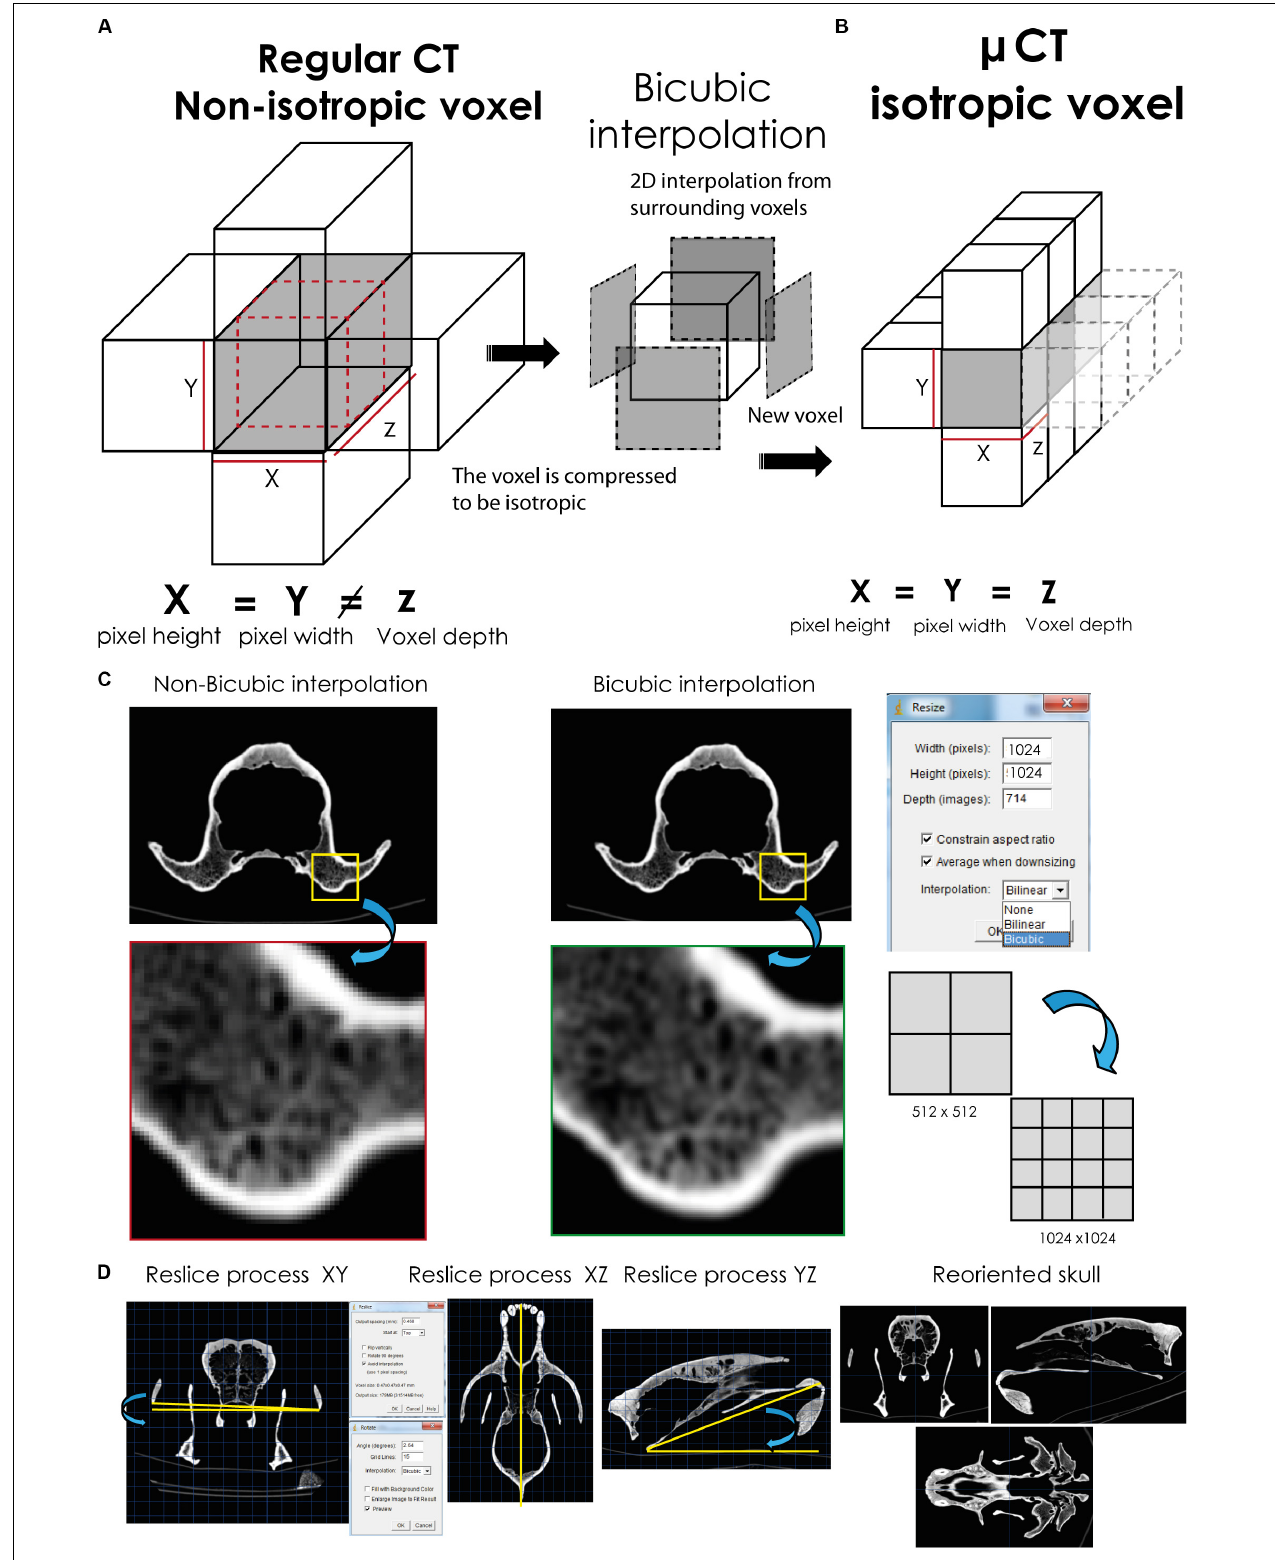
FIGURE 5 | Application of the bicubic interpolation to change the number of voxels in the three axes and to reorient the skull. The conversion from a non-isotropic voxel (A) to an isotropic one (B) is shown. (C) Increasing voxel size to improve the contrast of small structures. (D) Reorienting the XCT data.